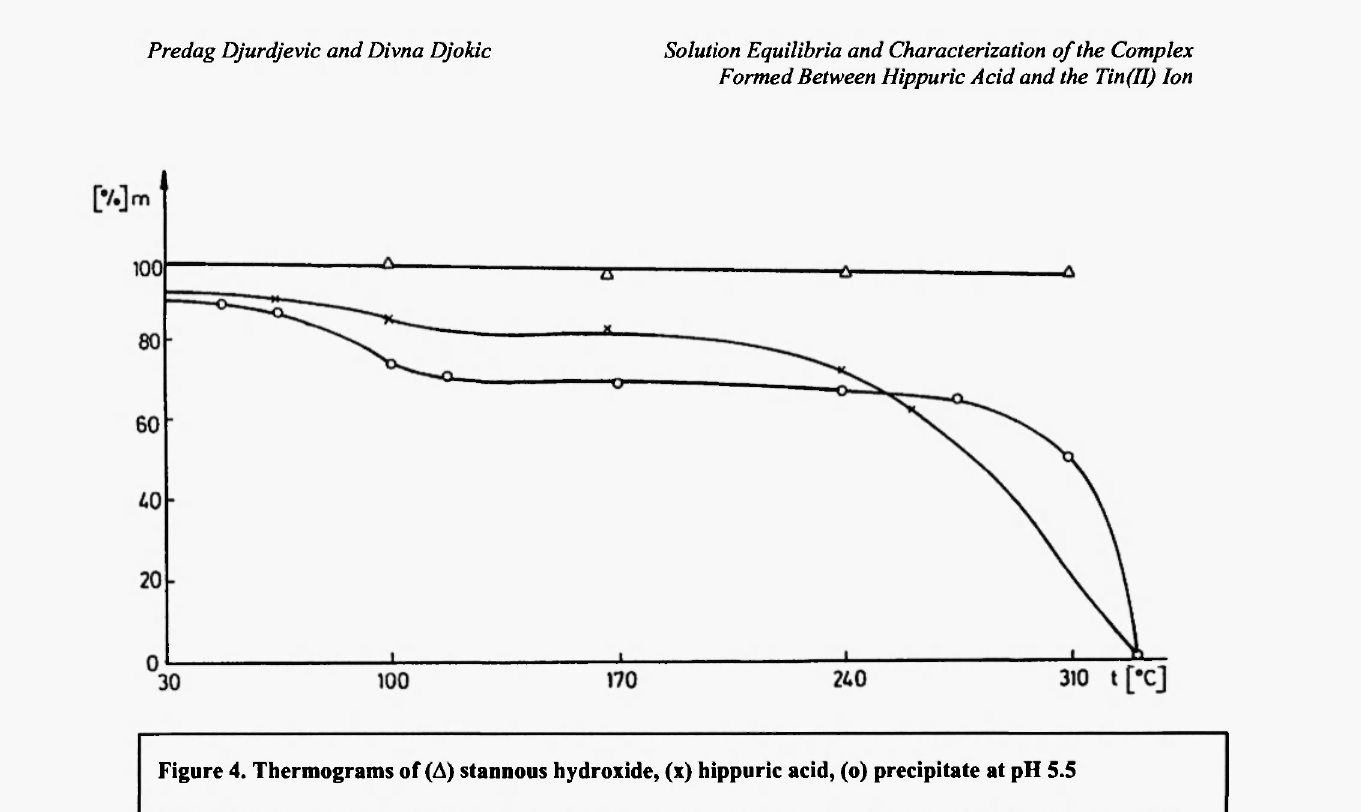
Table 1. X-ray powder diffraction data for tin(II) - hydroxide and tin(II) - hippuric acid precipitate obtained at pH 5.5. Θ is diffraction angle and d is interplanar distance in